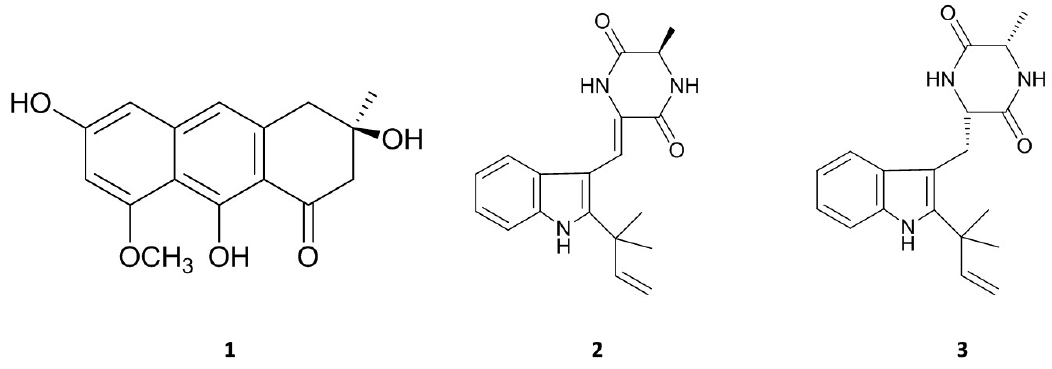
Figure 3. Chemical structures of three isolated compounds from marine-derived fungus, E. amstelodami.